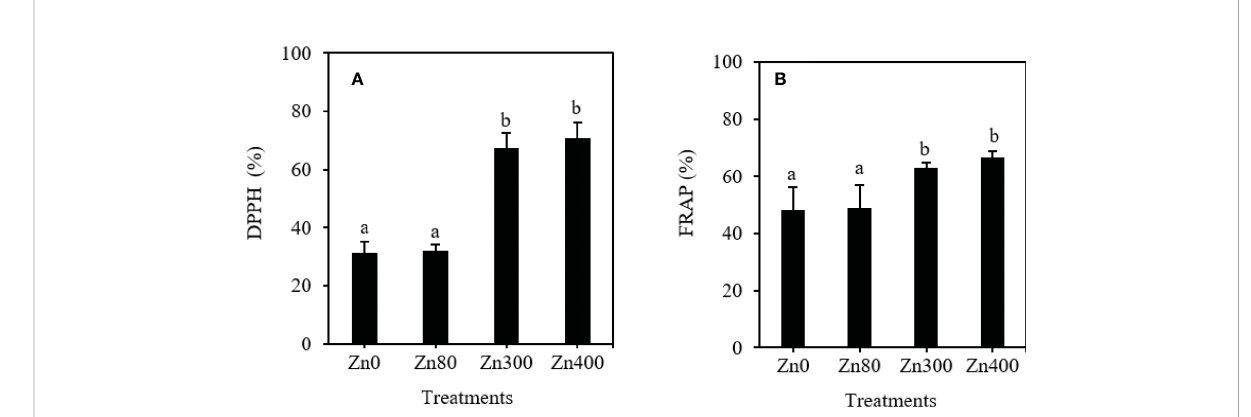
FIGURE 3 The scavenging ability of DPPH (A) and FRAP (B) of phenolic acids in leaves of Cdcontaminated K. obovata under different concentration of Zn treatments. The data are shown as the means ± SD ( n =3). DPPH, 1,1-diphenyl-2-picrylhydrazyl; FRAP, ferric-reducing antioxidant